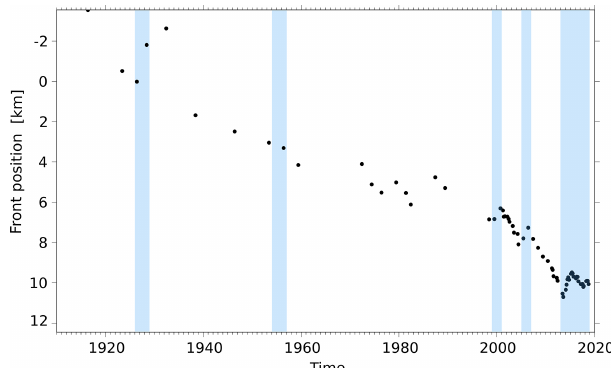
Figure 3. Average front position with respect to the terminus of 1916 consistent with the profile line shown in Fig. 1. The docu- mented surges are marked by light blue